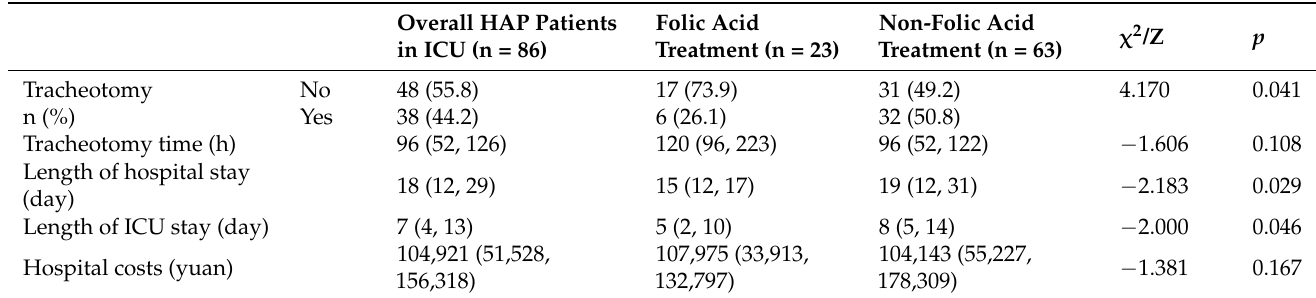
Table 2. Outcomes of overall ICU patients with HAP after TBI, folic acid treatment, and non-folic acid treatment group